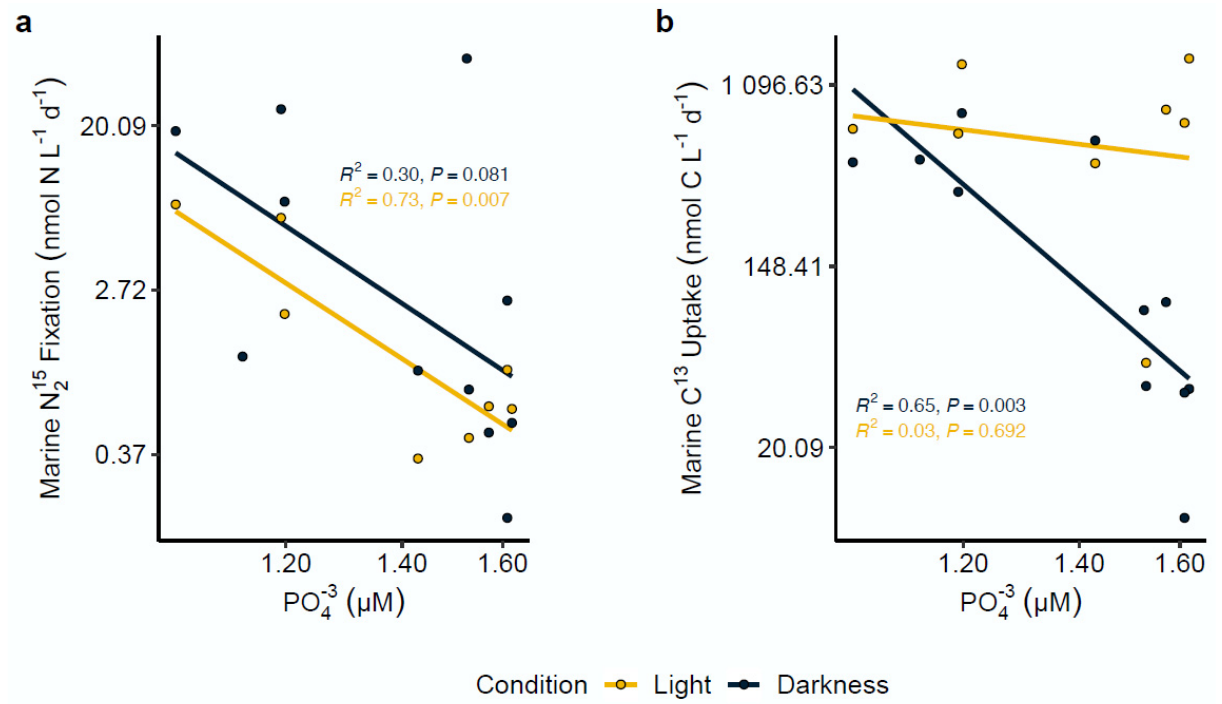
Figure 4. Nitrogen fixation and carbon assimilation rates in association with phosphate (PO 43 − ) concentrations. Light and dark nitrogen fixation ( a ) and carbon assimilation ( b ) were strongly correlated with PO 43 − concentrations in Chile Bay. All axes were transformed to log scale. R 2 and p -value significance values for each analysis are shown on each plot.